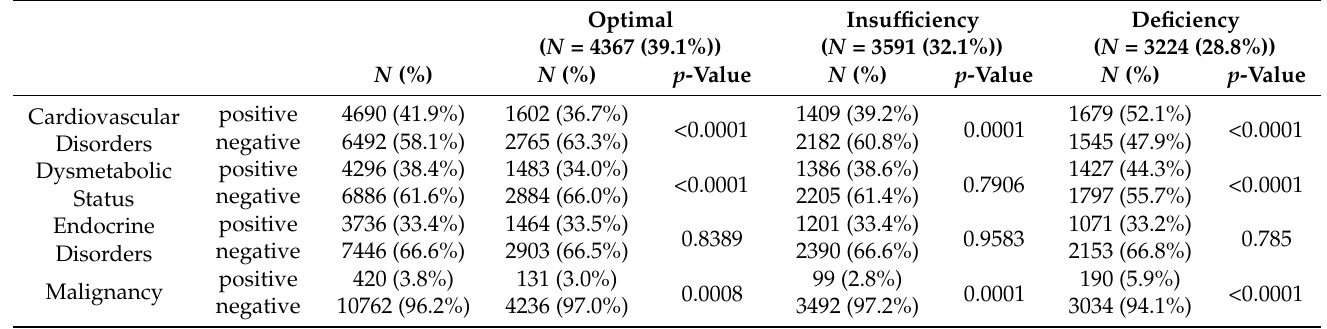
Table 4. Distribution of the vitamin D status depending on secondary diagnostic pathologies: cardiovascular disorders, dysmetabolic status, endocrine disorders and malignancy.